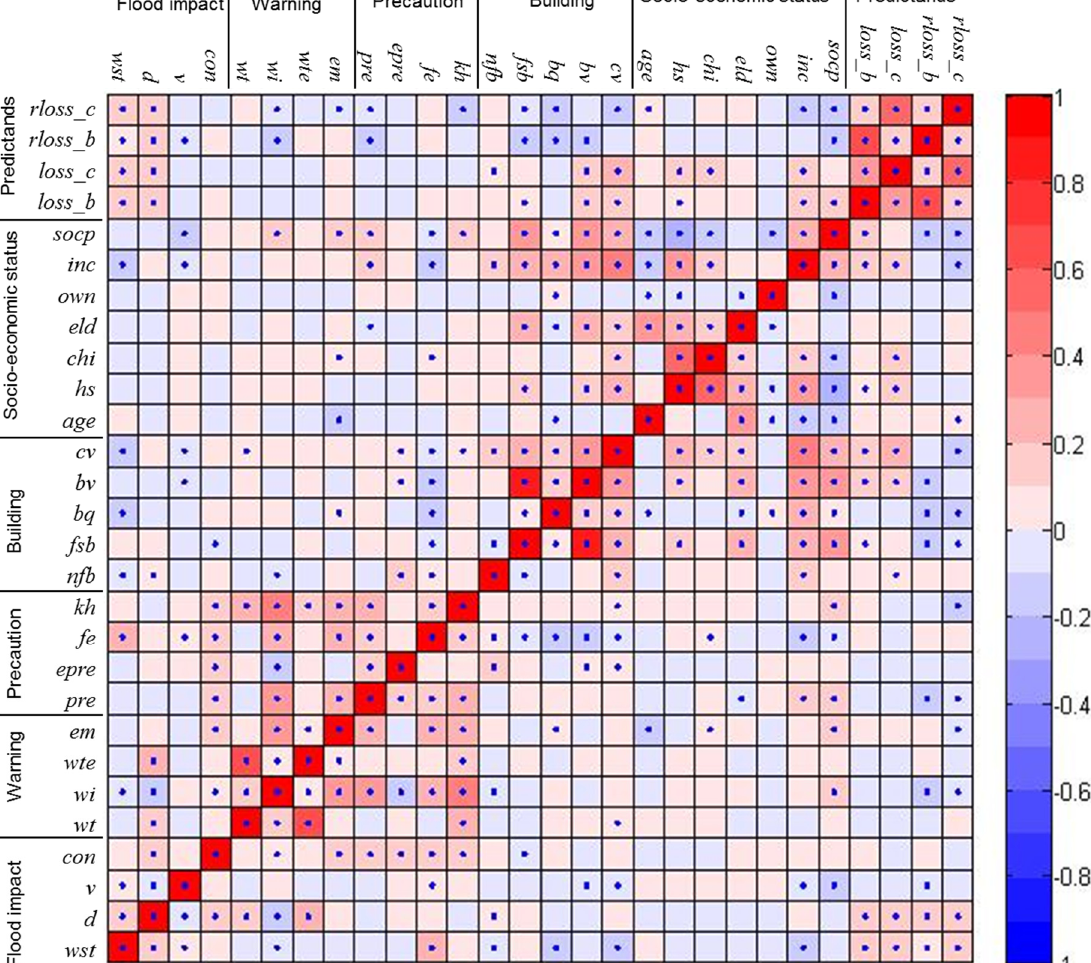
Table 8. The Pearson correlation coefficient of variables significantly correlated with absolute building loss, absolute content loss, building loss ratio and content loss ratio.